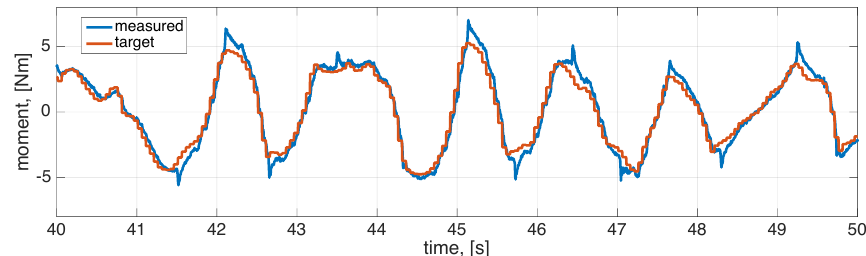
Figure 9. Comparison between target and measured moments on the model scale Wavestar WEC.